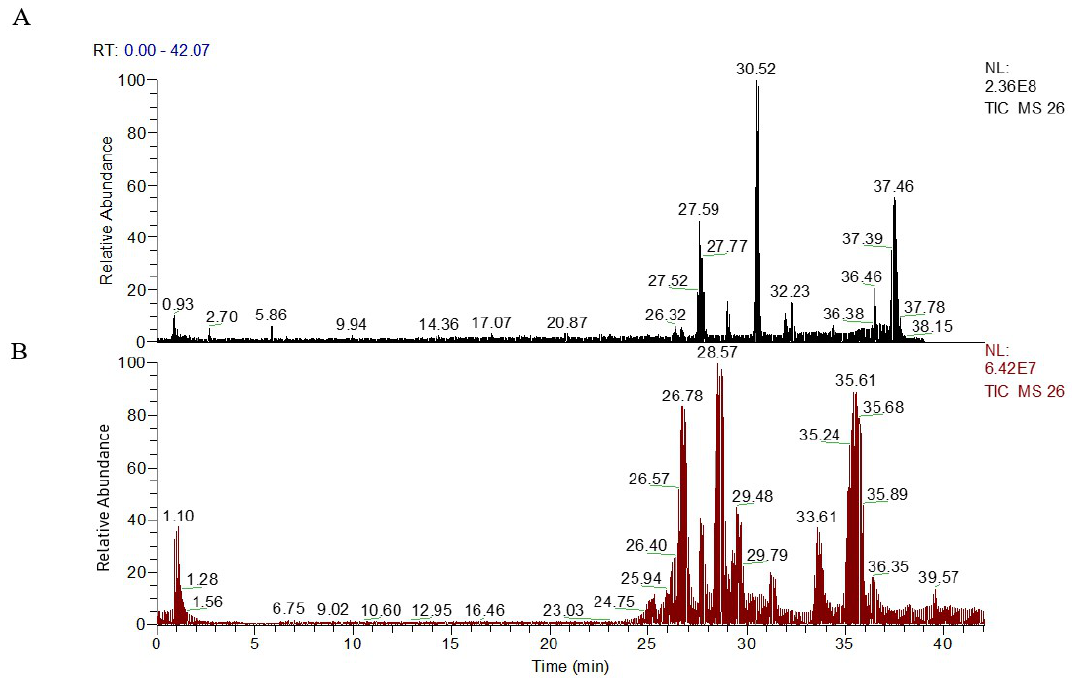
Figure 2. Representative UPLC-HR-MS total ion chromatograms (TICs) of serum samples from ESI + model ( A ), intensity of TIC = 2.36 × 10 8 ; and ESI − model ( B ), intensity of TIC = 6.42 × 10 7 .